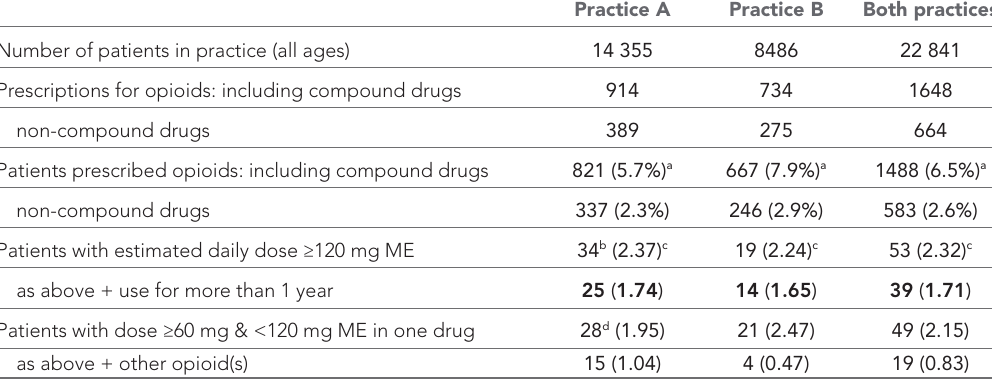
Table 2 Opioid prescribing in Practice A and Practice B in the index week